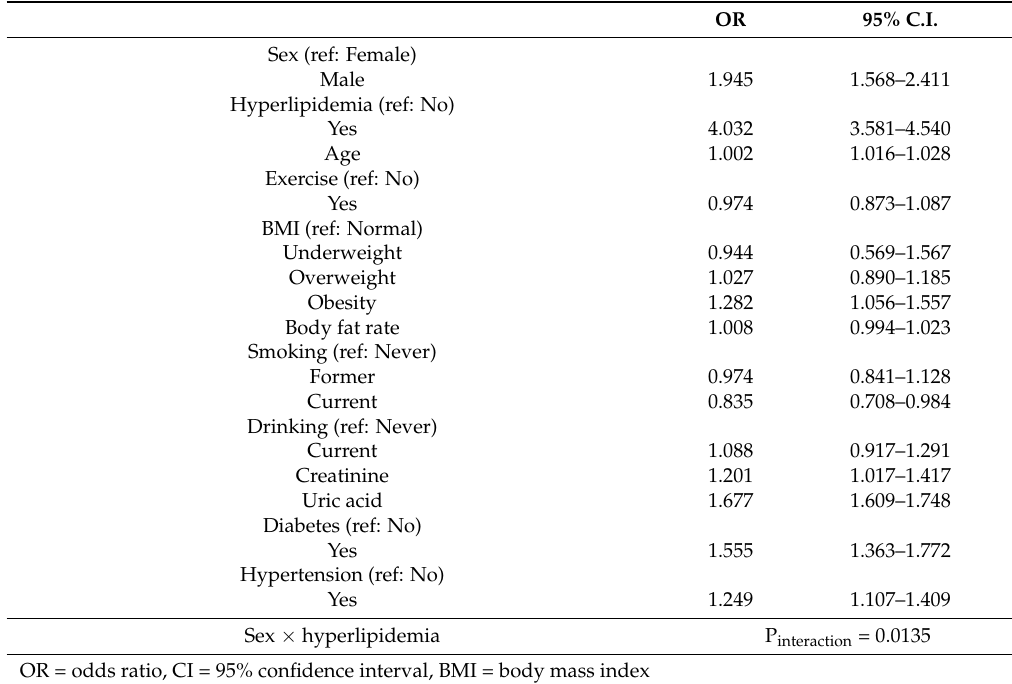
Table 2. Association of sex and hyperlipidemia with